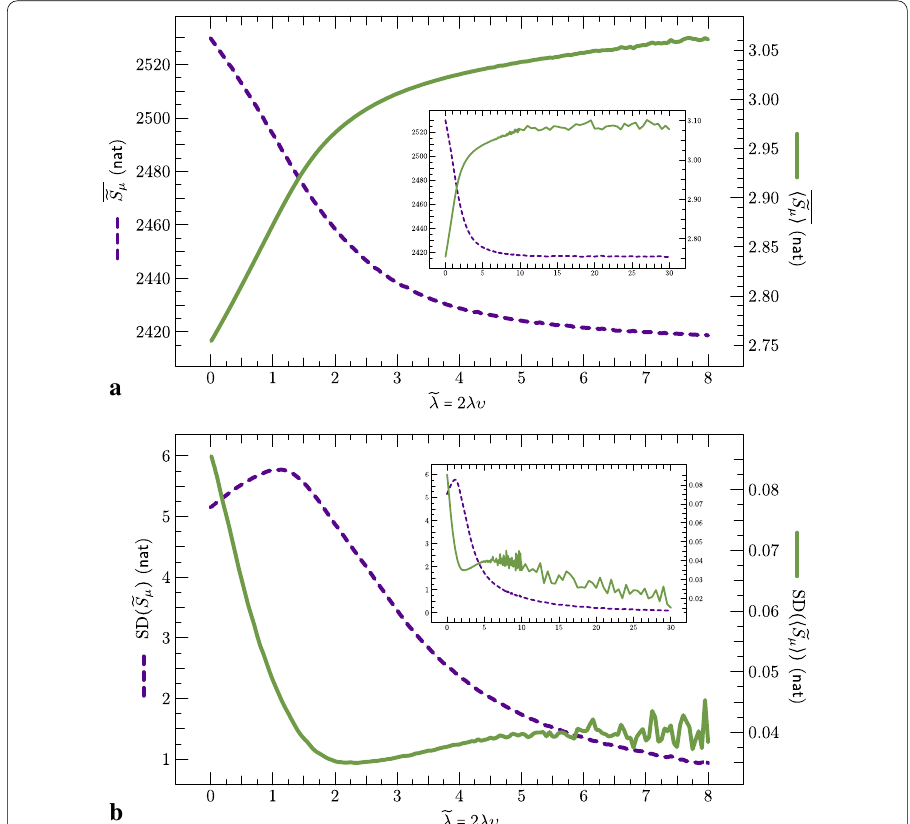
Fig. 7 Effective total and average amounts of surprisal versus effective scaling exponent for Central London (United Kingdom): green solid lines plot the mean (top) and standard-deviation (bottom) of the effective S µ (cid:30) ; purple dashed lines plot the mean (top) and standard-deviation (bottom) average amount of surprisal (cid:31) S µ ; the insets show their asymptotic behaviours. The annealing of the effective total amount of surprisal (cid:31) parameters are the same as in Fig. 6; the equilibria were assumed reached after the 5000th generation as in (cid:31) Fig. 6; the mean and standard-deviation values were computed over 250000 in-equilibrium generations and averaged over 10 simulations. (We attribute the noise that waves the asymptotic branches to the poor quality of our map data (see Footnote